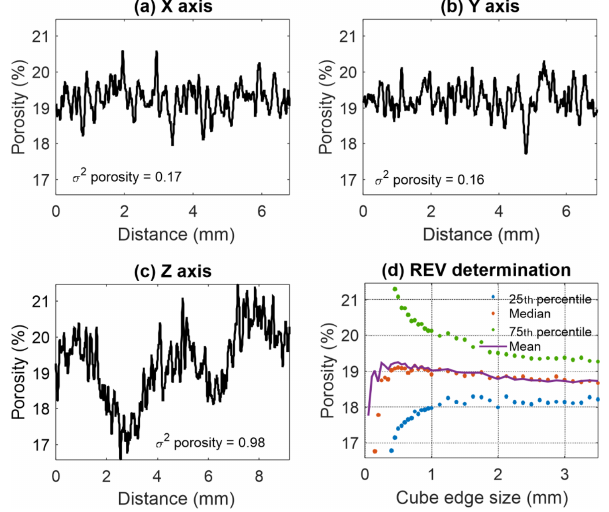
Figure 12. Determination of REV in S3. One-dimensional porosity profile of S3 slices evaluated in the (a) x direction, (b) y direction and (c) z direction. (d) Classic REV analysis. Investigated volume size is 3 × 3 × 4 . 2mm 3